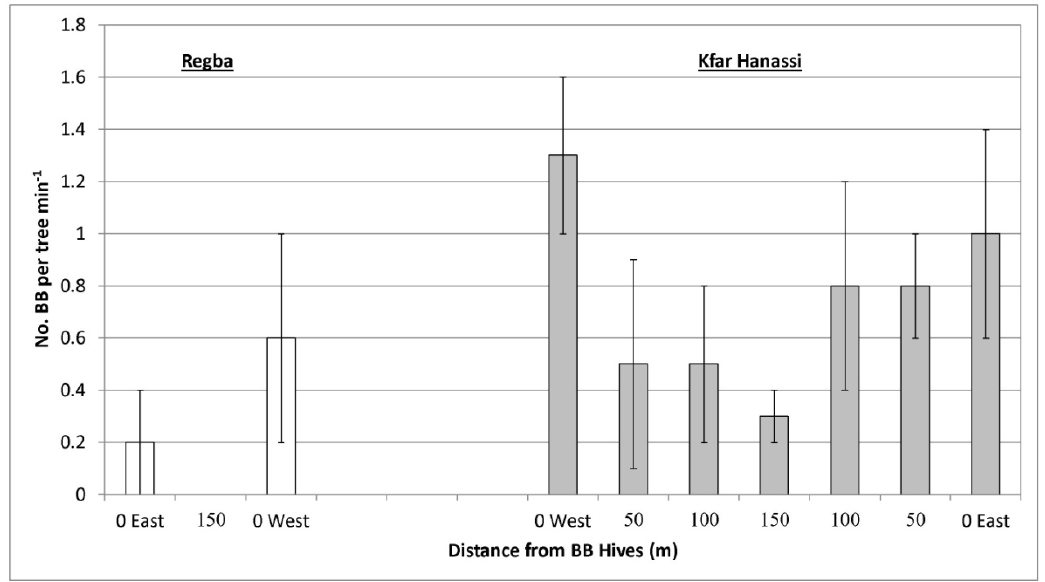
Figure 6. Number of bumblebees (BBs) on ‘Hass’ trees at three distances (Kfar Hanassi, 2 May 2019) or seven distances (Regba, 5 May 2019) from the BB hives. Data are the means of five ‘Hass’ trees at each distance ± SE.